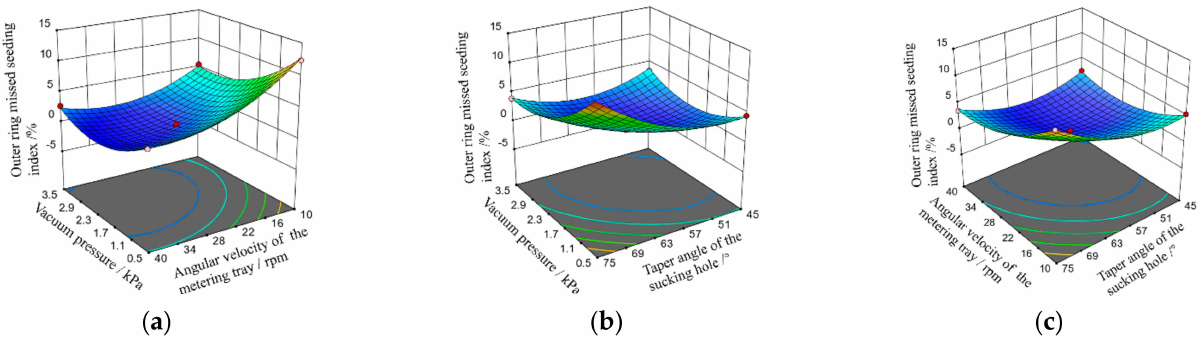
Figure 10. Effect of ( a ) angular velocity of metering tray and vacuum pressure, ( b ) taper angle of sucking hole and vacuum pressure, and ( c ) taper angle of sucking hole and angular velocity of metering tray on the outer ring missed seeding index.